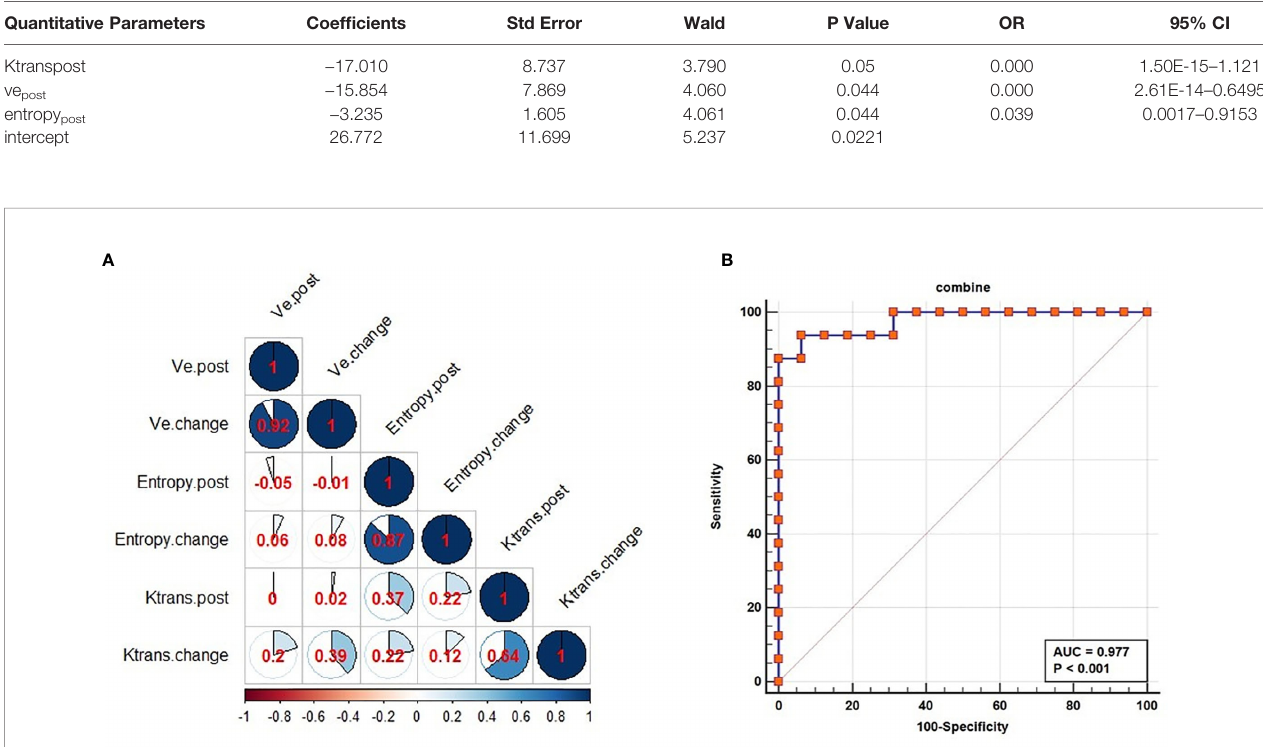
FIGURE 4 | Performance of combined parameters for diagnosis in NACRT. Correlation coef fi cients for all parameters (A) ; the AUC value for the combination of the parameters was 0.977 (B)